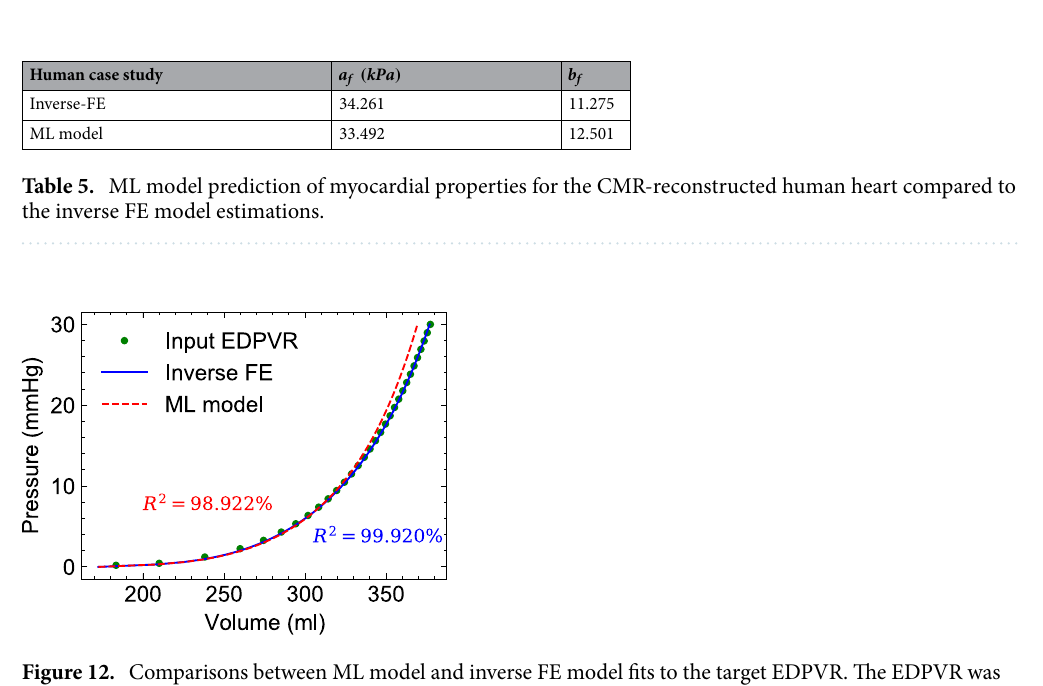
Figure 12. Comparisons between ML model and inverse FE model fits to the target EDPVR. The EDPVR was generated using Klotz’s approach and patient-specific imaging data for a mitral-valve prolapse (MVP) patient. A population average end-diastolic pressure for MVP patients was used to generate the target